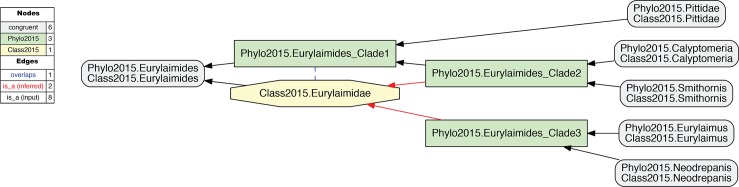
Alignment visualization corresponding to Fig 5.The alignment shows an overlapping articulation (dashed blue line) between the phylogenomic clade concept sec. 2015.PEA (Phylo2015.Passeriformes_Clade1) and the Eurylaimidae sec. Gill & Donsker (2015) [20] (Class2015.Eurylaimidae). The two dashed red arrows symbolize reasoner-inferred relationships not explicit in the input constraints. See also S6 File.